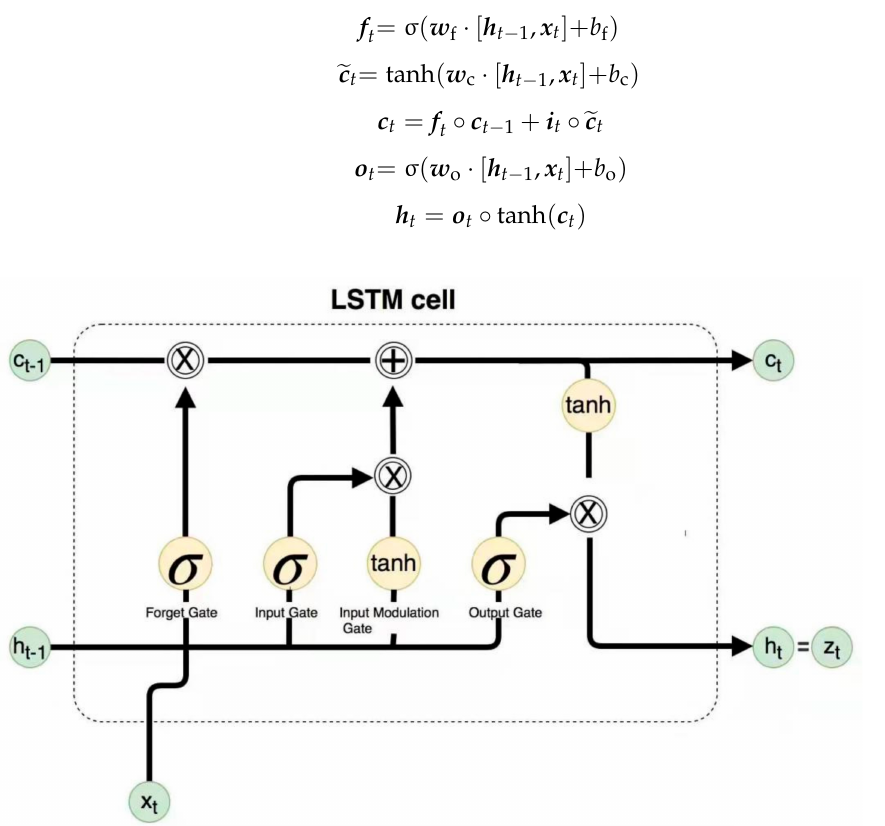
Figure 1. The LSTM neural network